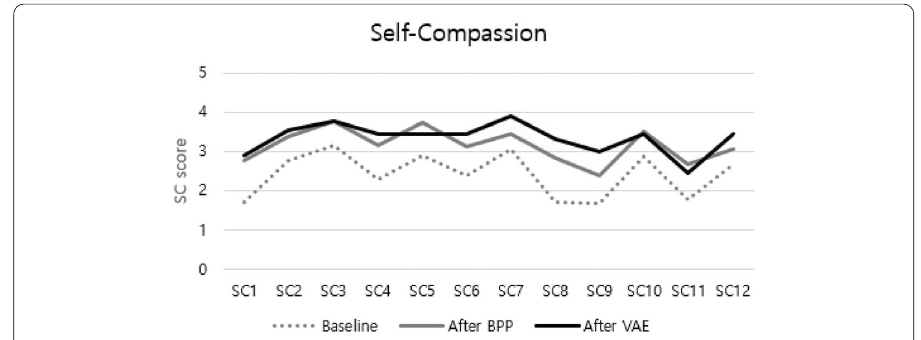
Fig. 6 Changes of self-compassion scores across the intervention